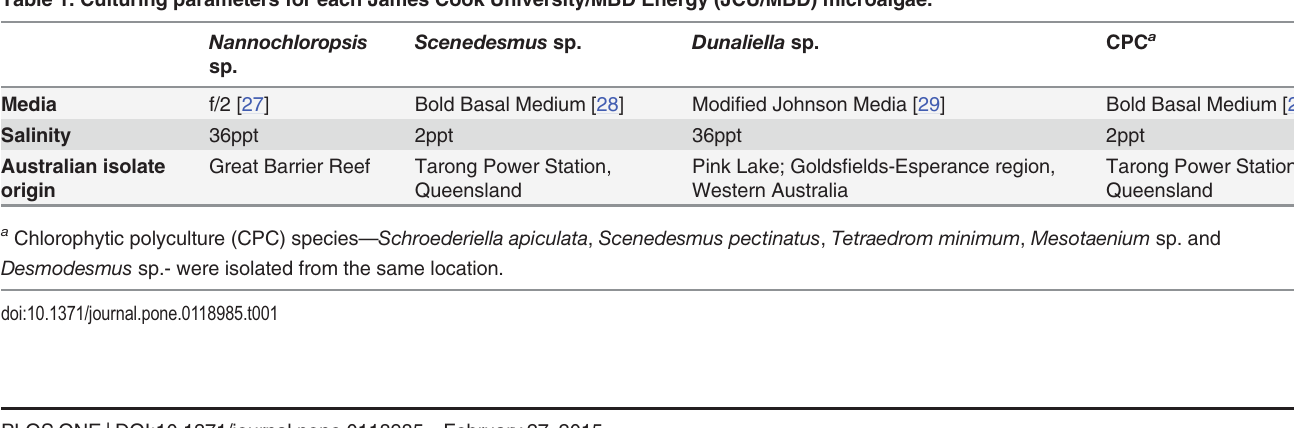
Table 1. Culturing parameters for each James Cook University/MBD Energy (JCU/MBD)